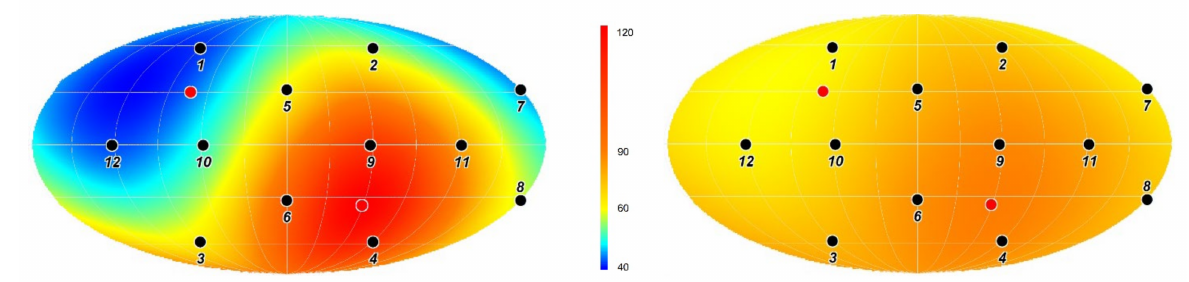
Figure 15. Spatial distribution of NH 3 after 100 Martian years: “factory” alternative variant ( left ), “asteroid” alternative variant ( right ).